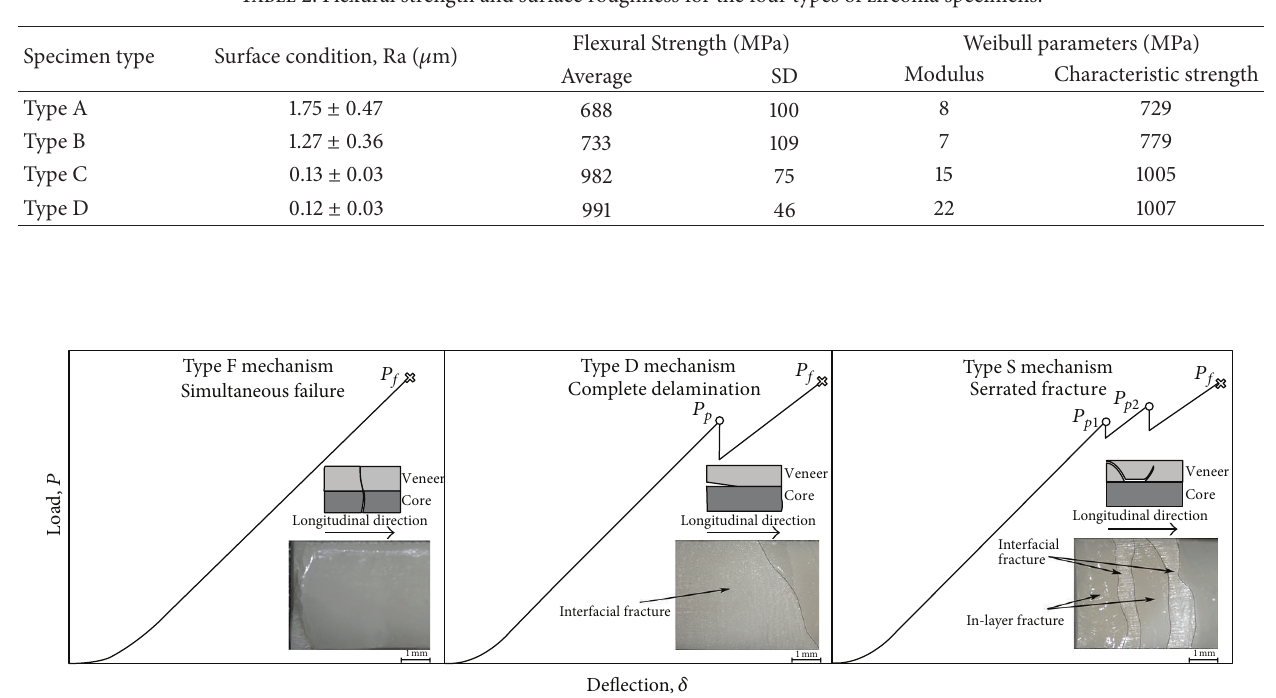
Table 2: Flexural strength and surface roughness for the four types of zirconia specimens.